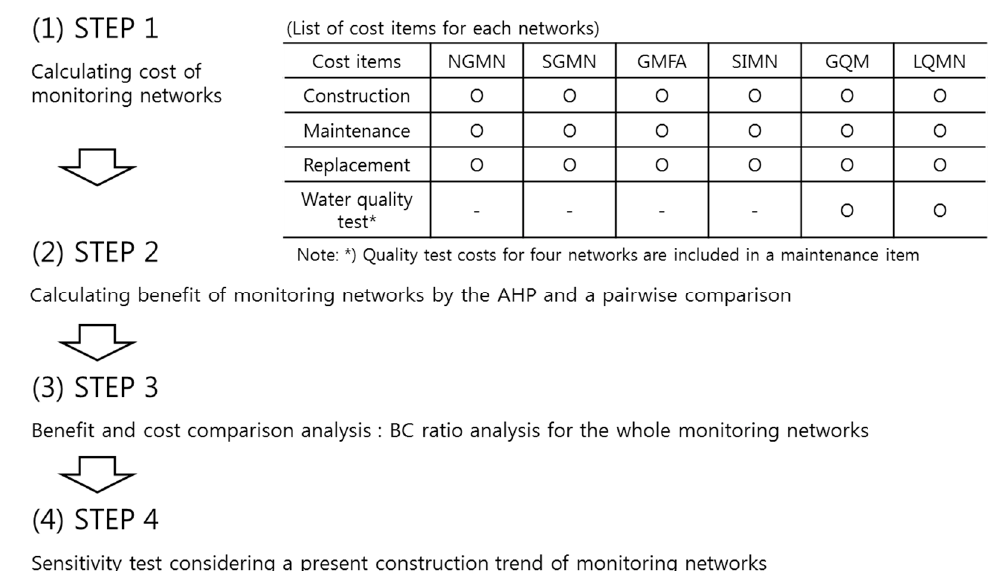
Figure 2. Research procedure of cost-benefit analysis for groundwater monitoring networks.